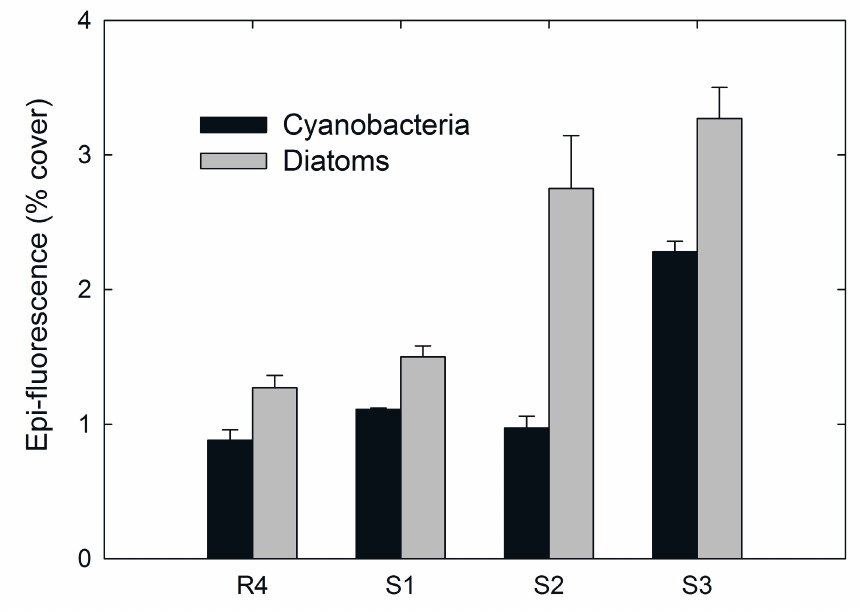
Figure 4. Mean (+SE) epi-fluorescence of epipelic diatoms and cyanobacteria sampled from the surface sediment at each station ( n =